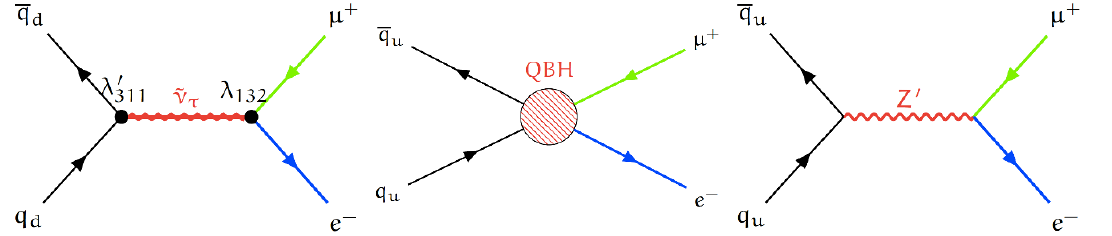
Figure 1 . Leading order Feynman diagrams considered in our search. Left: resonant production of a (cid:28) sneutrino in an RPV SUSY model that includes the subsequent decay into an electron and a muon. The (cid:23) (cid:28) is produced from the annihilation of two down quarks via the (cid:21) 0 e then decays via the (cid:21) 132 = (cid:21) 231 couplings into the electron muon (cid:12)nal state. Middle: production of quantum black holes in a model with extra dimensions that involves subsequent decay into an electron and a muon. Right: resonant production of a Z 0 boson with subsequent decay into an electron and a